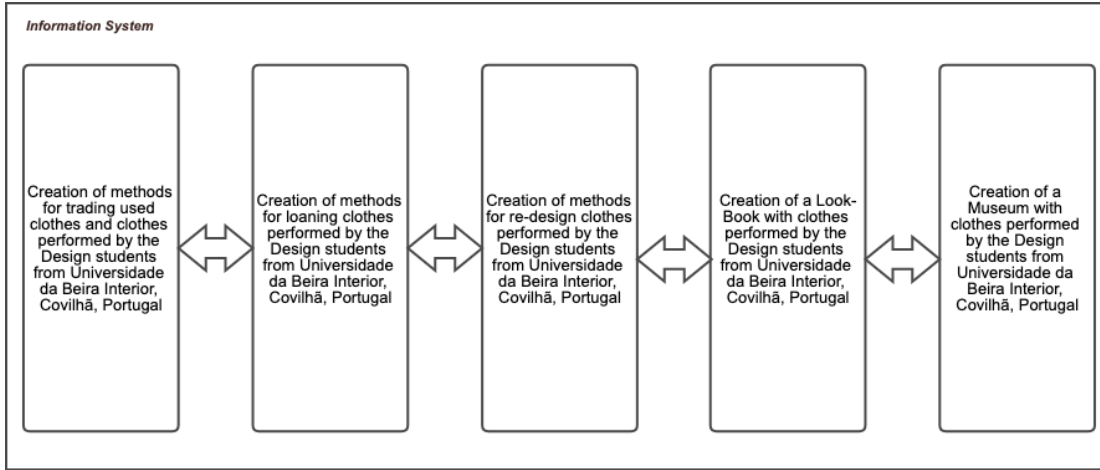
Figure 6. Design of a system for Sustainability design for students from Universidade da Beira Interior, Covilhã,